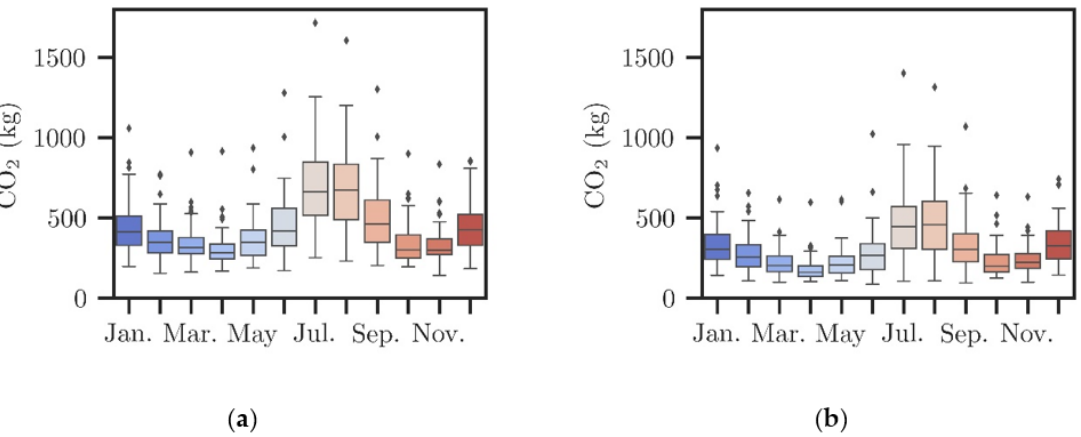
Figure 10. Household CO 2 emissions from electricity consumption; ( a ) no PV generator installed; ( b ) 3 kWp PV generator installed. (n =